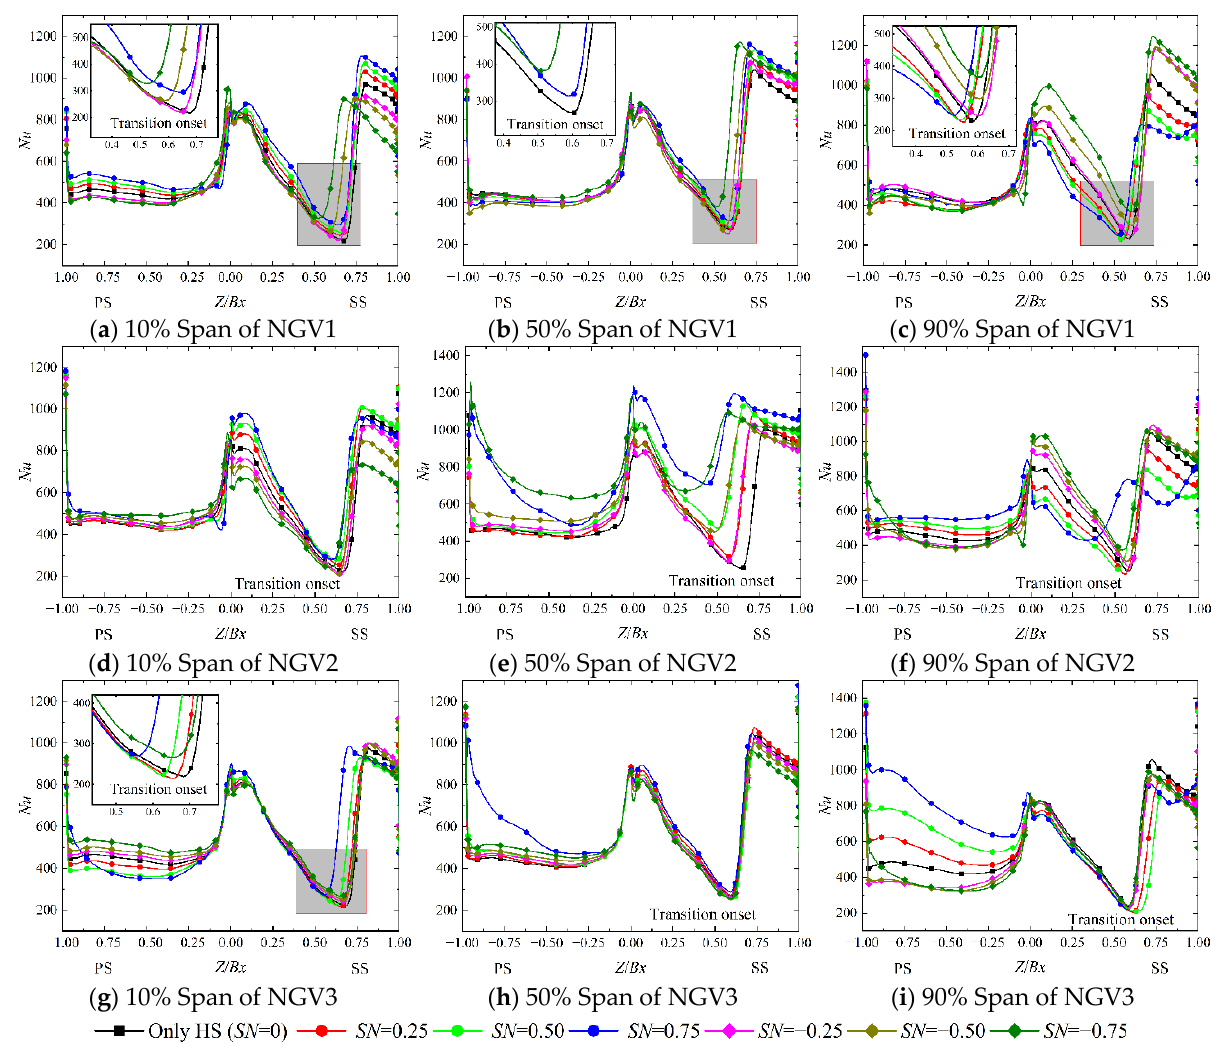
Figure 22. Nusselt number distributions on NGV surfaces (from left to right are NGV1, NGV2 and NGV3, respectively).